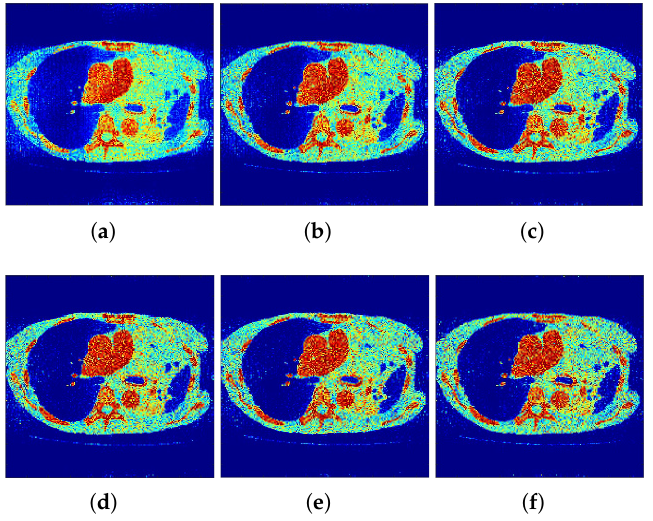
Figure 3. Conventional MLEM reconstructions. ( a – c ) row: iterations 20, 40, and 60. ( d – f ) row: iterations 80, 100, and